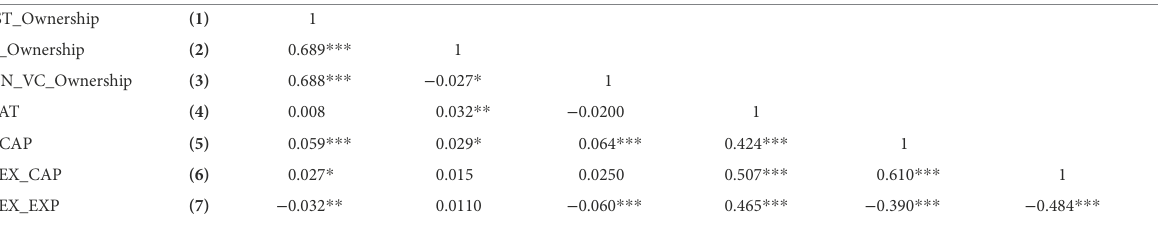
TABLE 2 Correlation